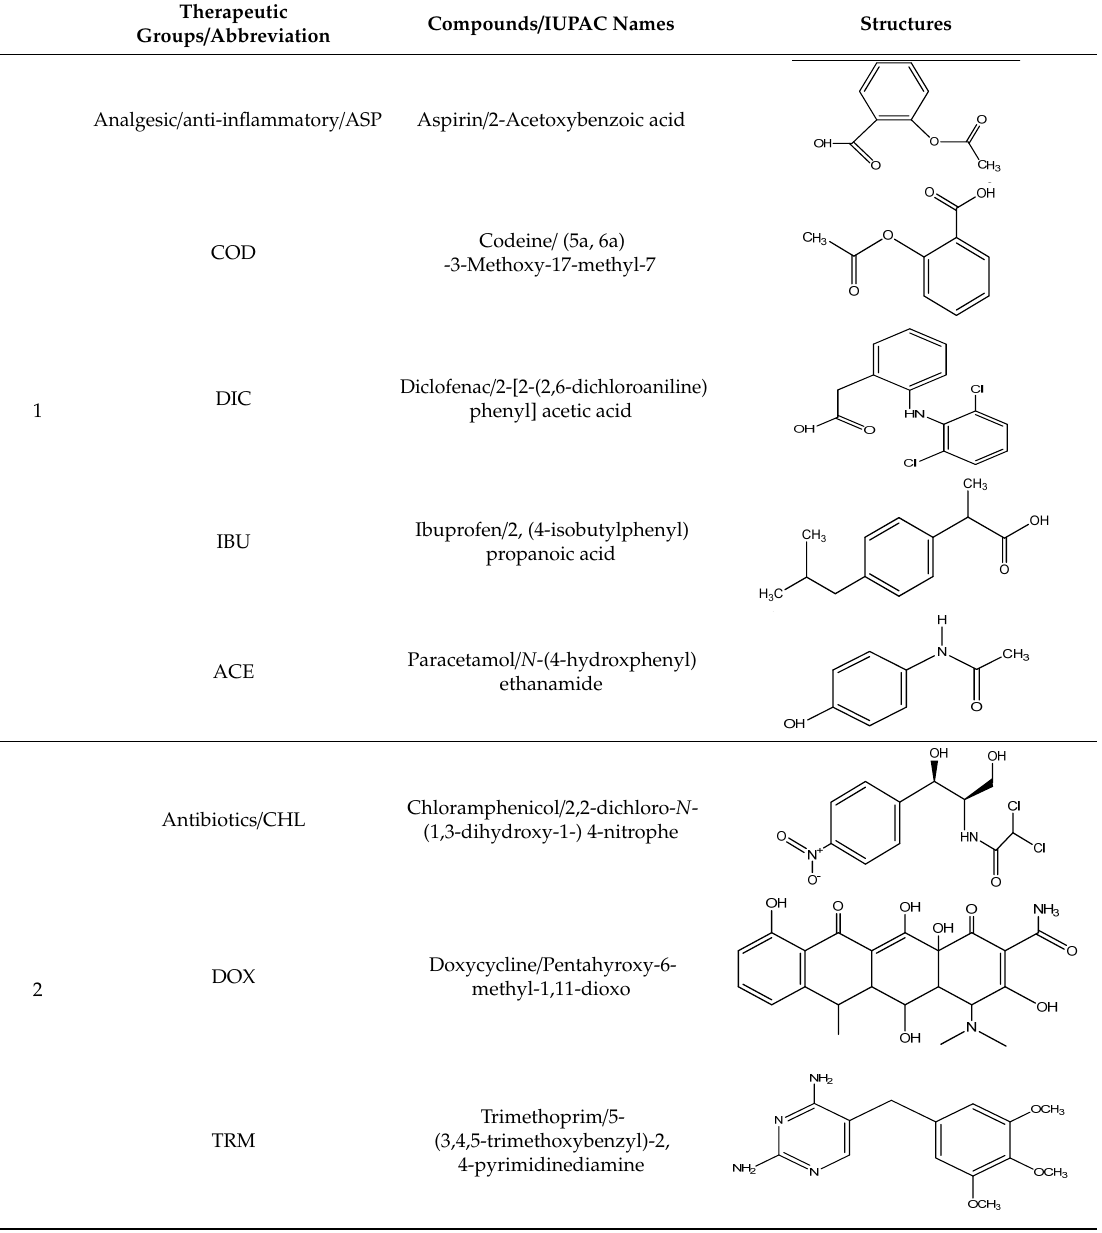
Table 4. Therapeutic groups, compounds / IUPAC names and structures of 13 PPCPs studied. Table 4. Therapeutic groups, compounds/IUPAC names and structures of 13 PPCPs studied. Table 4. Therapeutic groups, compounds/IUPAC names and structures of 13 PPCPs studied. Table 4. Therapeutic groups, compounds/IUPAC names and structures of 13 PPCPs studied. Table 4. Therapeutic groups, compounds/IUPAC names and structures of 13 PPCPs studied. Table 4. Therapeutic groups, compounds/IUPAC names and structures of 13 PPCPs